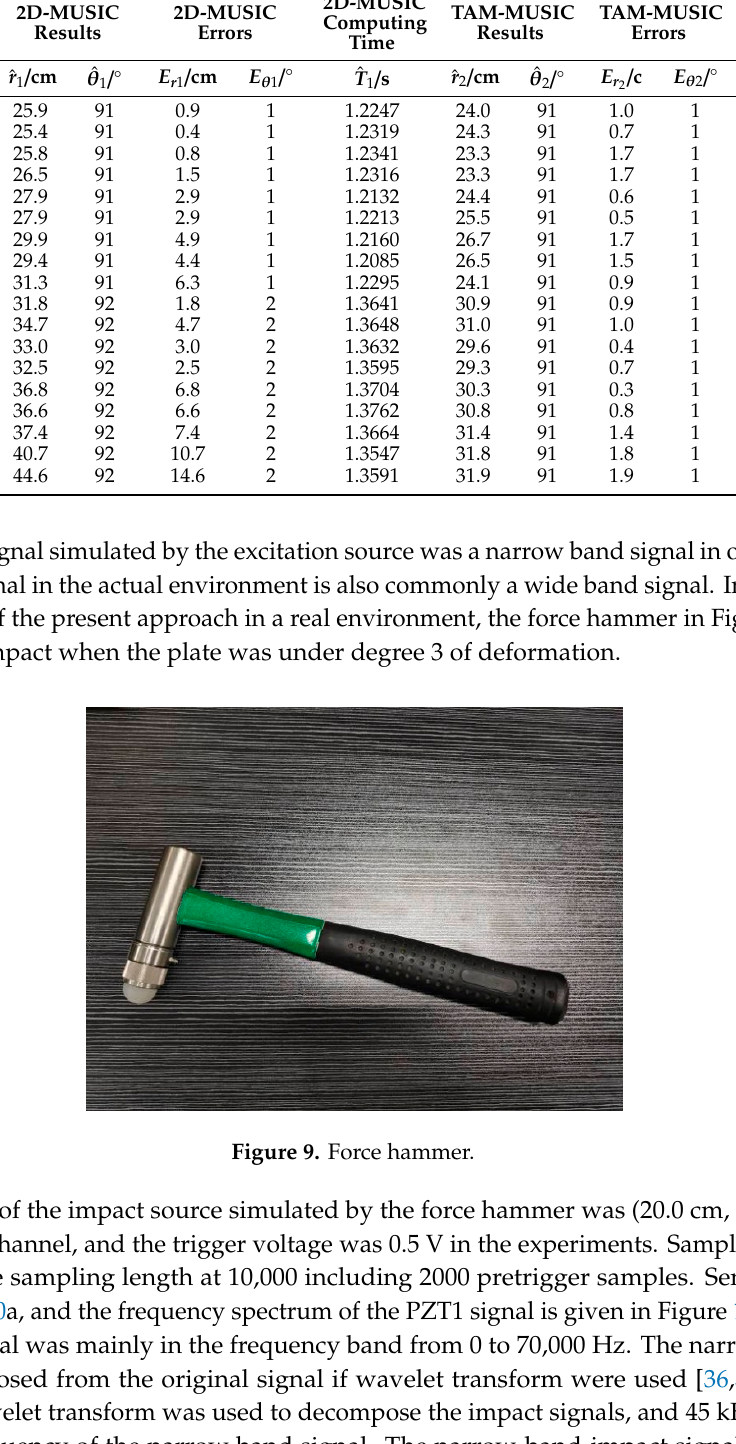
Table 1. Localization results of two methods under deformation. MUSIC, multiple-signal classification.